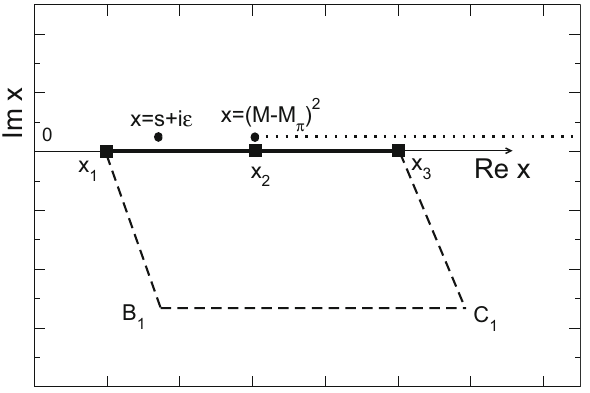
Fig. 3 Integration paths for the singular integral G ( s ) in (10). The original path runs along the real line, from x 1 to x 3 (solid line). The upper horizontal line (dotted) stands for the cut attached to the branch point at x = ( M − M π ) 2 . The two singularities of the integrand are indicatedwithfilledcircles.Sincethesearelocatedintheuppercomplex plane, the path may be deformed into the lower half plane, e.g., into the polygonal line x 1 B 1 C 1 x 3 (dashed line), without changing the value of the integral. See Appendix A for x i , B 1 , C 1